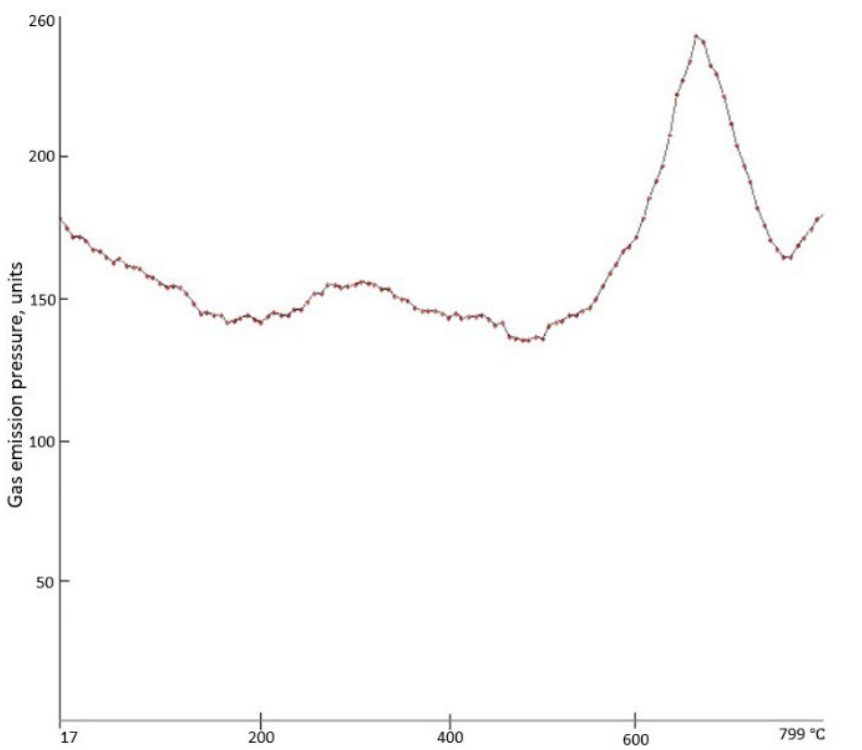
Figure 6. Changes in the total gas release from the PCS fibers when heated in the mass spectrometer.